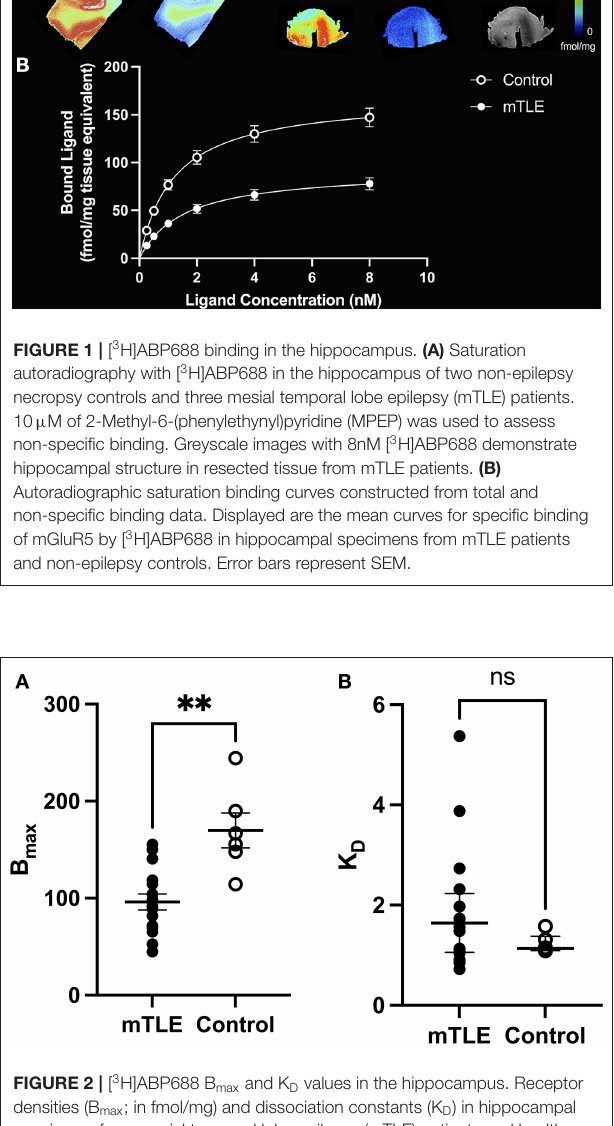
model that explained 54% of the variance of B max :